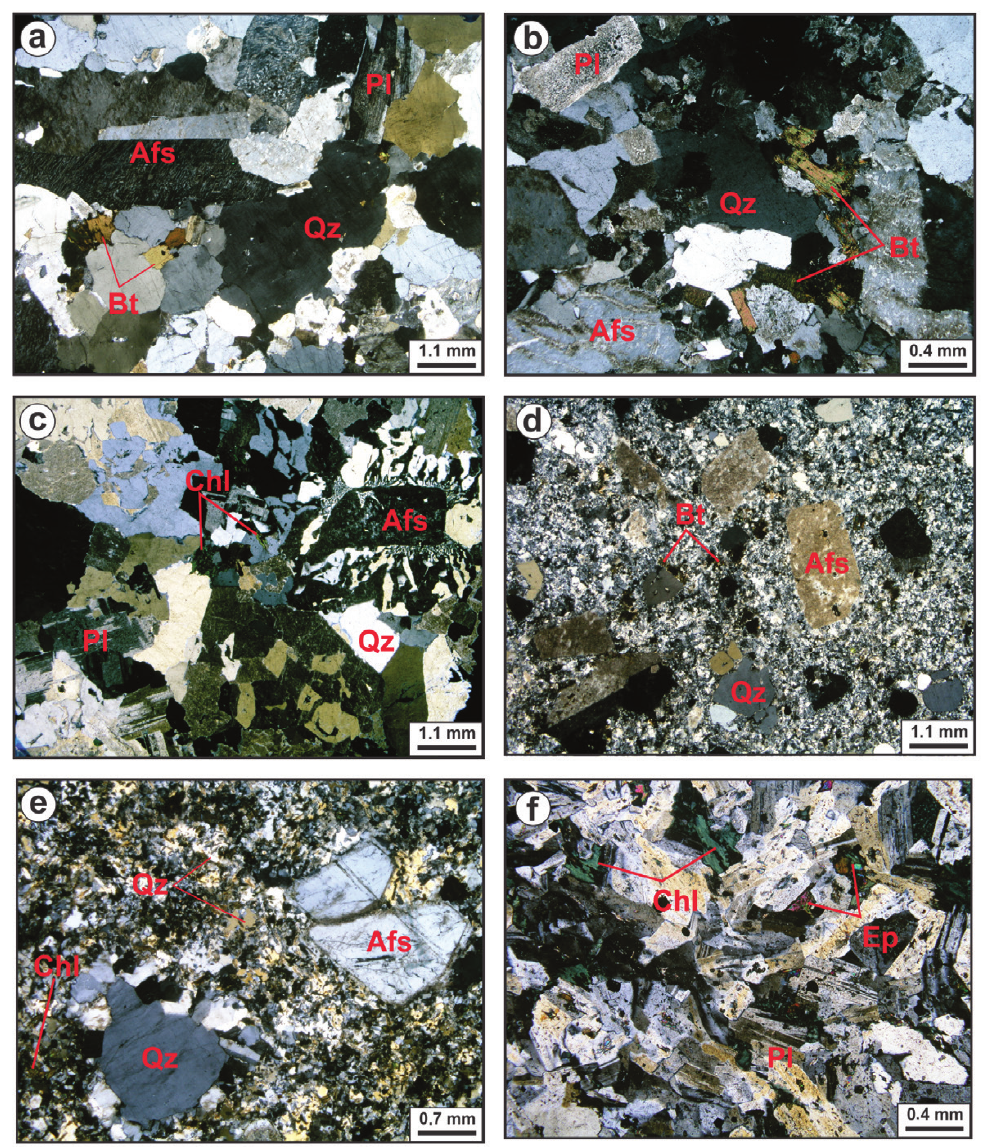
Figure 7 - Microtextural features of the Quiriri Pluton. (a) Textural aspect of massive, medium-grained inequigranular syenogranite of Q1 facies with slightly larger pertitic alkali feldspar crystals (Afs) and minor plagioclase (Pl), quartz (Qz) and interstitial biotite (Bt) crystals. (b) Textural aspect of massive, fine to medium-grained syenogranite of Q2 facies showing equi to inequigranular texture made of slightly larger alkali feldspar (Afs) and quartz (Qz) crystals, minor saussuritic plagioclase (Pl) and euhedral biotite. (c) Textural aspect of massive, medium grained, plagioclase-poor syenogranite of Q3 facies, with a inequigranular texture defined by alkali feldspar crystals (Afs) in granophyric intergrowths with quartz (Qz), scarce plagioclase (Pl) and interstitial chlorite (Chl) pseudomorphs after biotite. (d) Textural aspect of porphyritic syenogranite (granite porphyry) of Q4 facies with sericitic and red-clouded alkali feldspar (Afs) and globular quartz (Qz) megacrysts in a fine-grained quartz-feldspatic matrix with chlorite (Chl) pseudomorphs after biotite. (e) Textural detail of microgranular monzogranitic enclave within syenogranite of Q1 facies showing euhedral alkali feldspar (Afs) and globular quartz (Qz) megacrysts (xenocrysts?) in a fine-grained matrix of poikilitic quartz (Qz), minor plagioclase, some alkali feldspar and chlorite (Chl) pseudomorphs after biotite. (f) Detail of leucocratic enclave within syenogranite of Q1 facies, made essentially of euhedral plagioclase crystals (Pl), as well as chlorite (Chl) and epidote (ep) pseudomorphs after biotite and/or amphibole. Photomicrographs with crossed